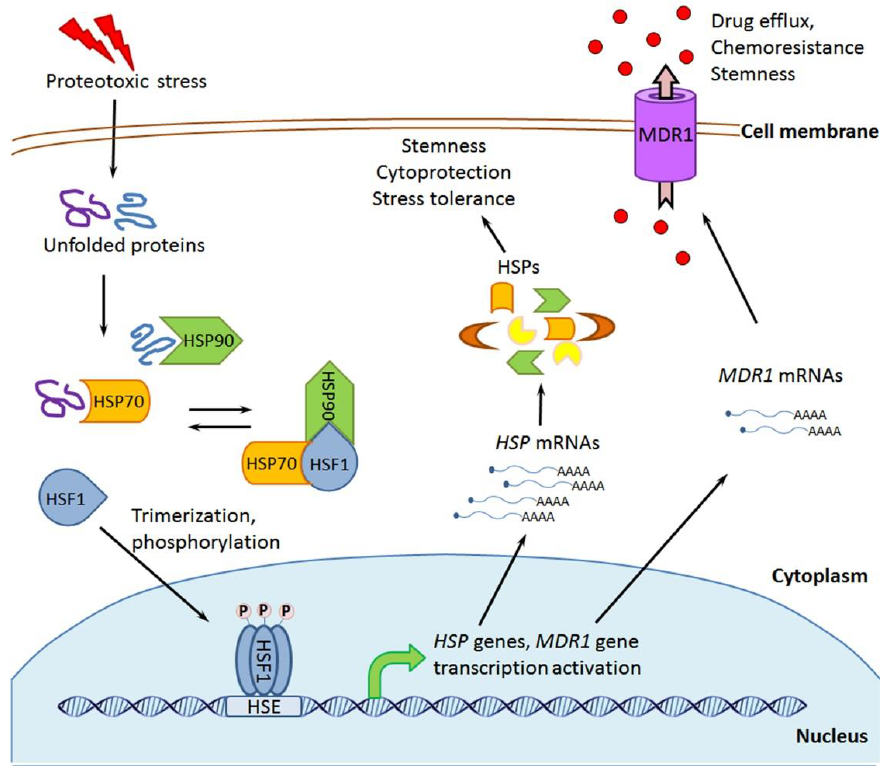
Figure 3. A scheme showing a mechanism of the HSF1-mediated heat stress transcription response resulting in the expression of heat shock protein (HSP) and multidrug resistance 1 (MDR1) genes whose protein products contribute to cytoprotection from stresses, drug resistance, and also to the cancer stemness. Cytosolic HSP90 and HSP70 bind to and passivate HSF1, thus preventing its activation under normal conditions. Whenstress-damagedproteinsaccumulateinthecytoplasm,theyrecruitHSP70andHSP90from the inactivating complex with HSF1, so that the latter is activated via its phosphorylation and trimerization, then binds to the heat shock element (HSE) sequence in promoter regions of HSP genes, and thus triggers the expression of all inducible HSPs. As the MDR1 gene is known to have the HSE-containing promoter, MDR1 expression can also be initiated by activated HSF1 [29].